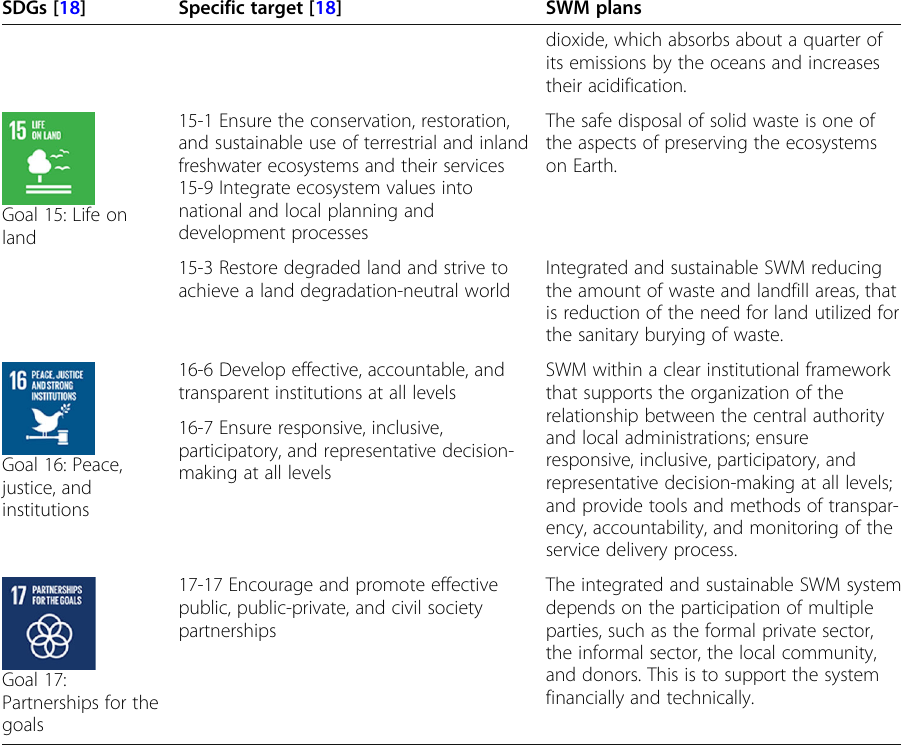
Table 1 The contribution of SWM on SDGs achievement [the author] (Continued)